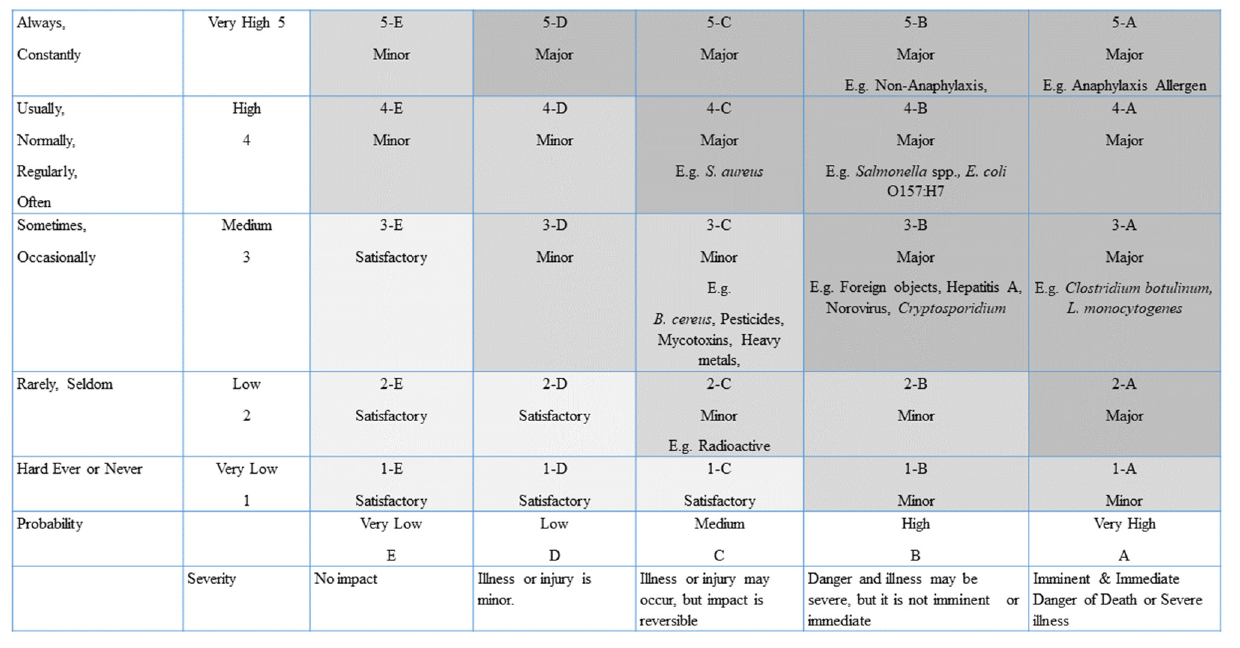
Figure 4. Practical fruit and vegetable 5 × 5 food safety matrix model. Table 6. Comparison of all significant hazards in each practical fruit and vegetable qualitative food safety risk matrix models with Tables 16 and 17 (FDA,